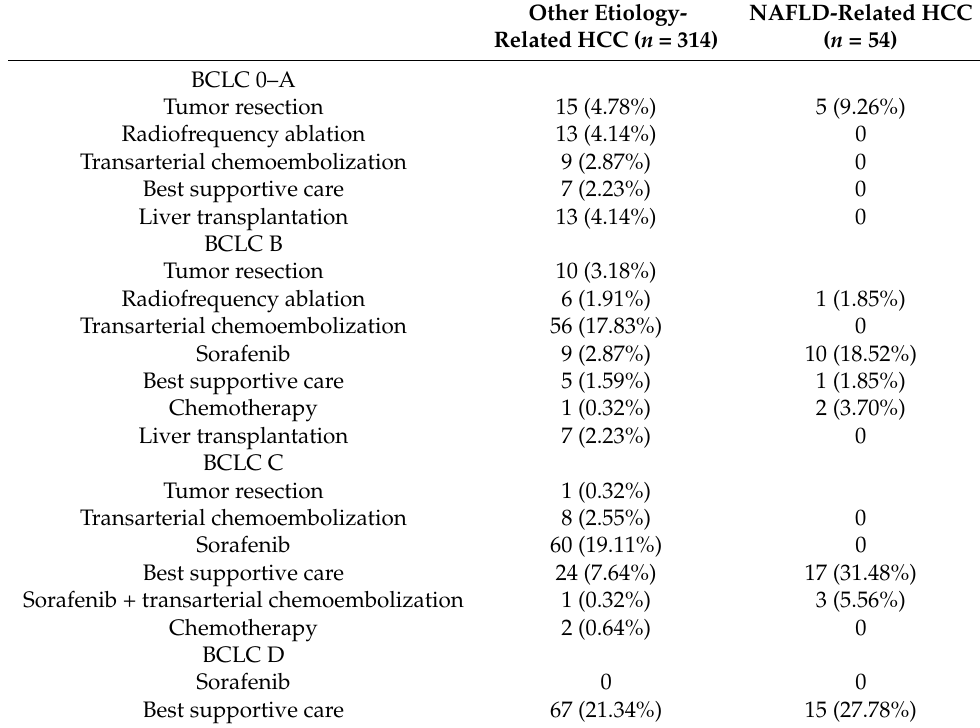
Table 2. Treatment of patients with hepatocellular